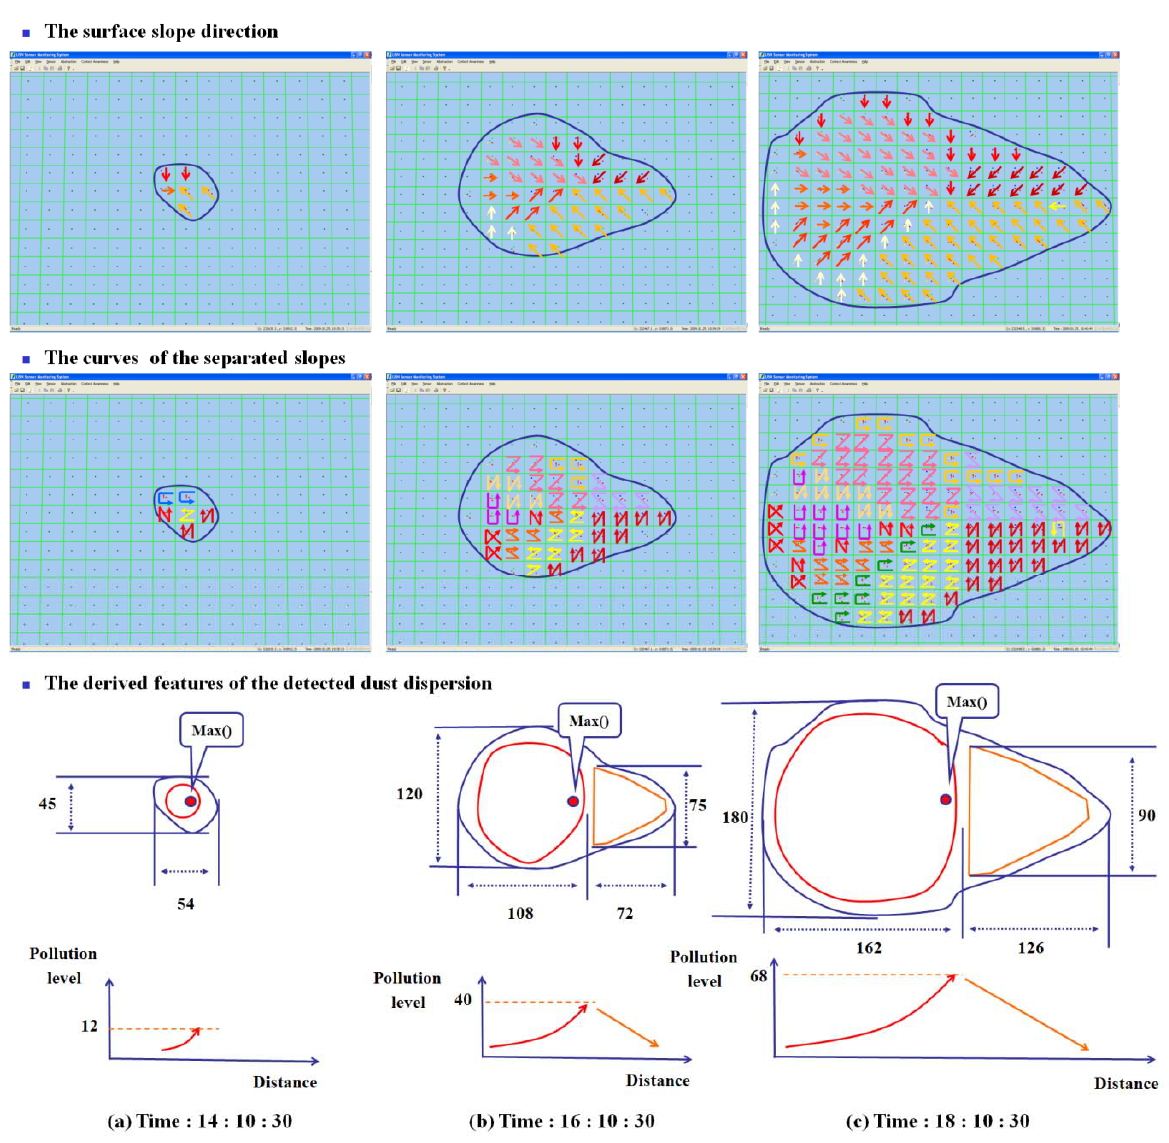
Figure 12. The curves of LSGSA and the extracted features of the